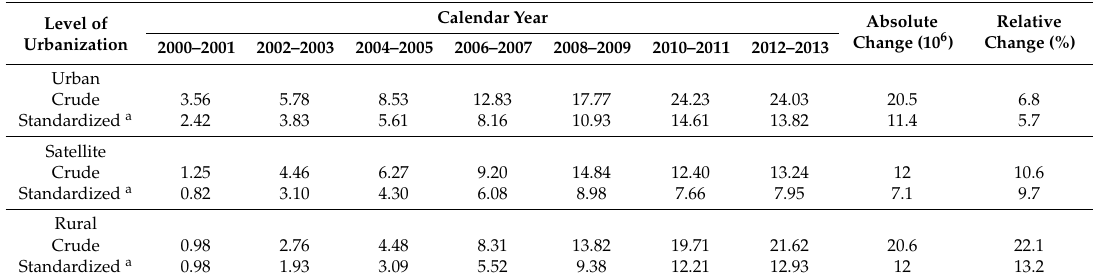
Table 2. Crude and age ‐ sex ‐ standardized biennial prevalence of liver transplantation in Taiwan, 2000–2013. Level of Urbanization